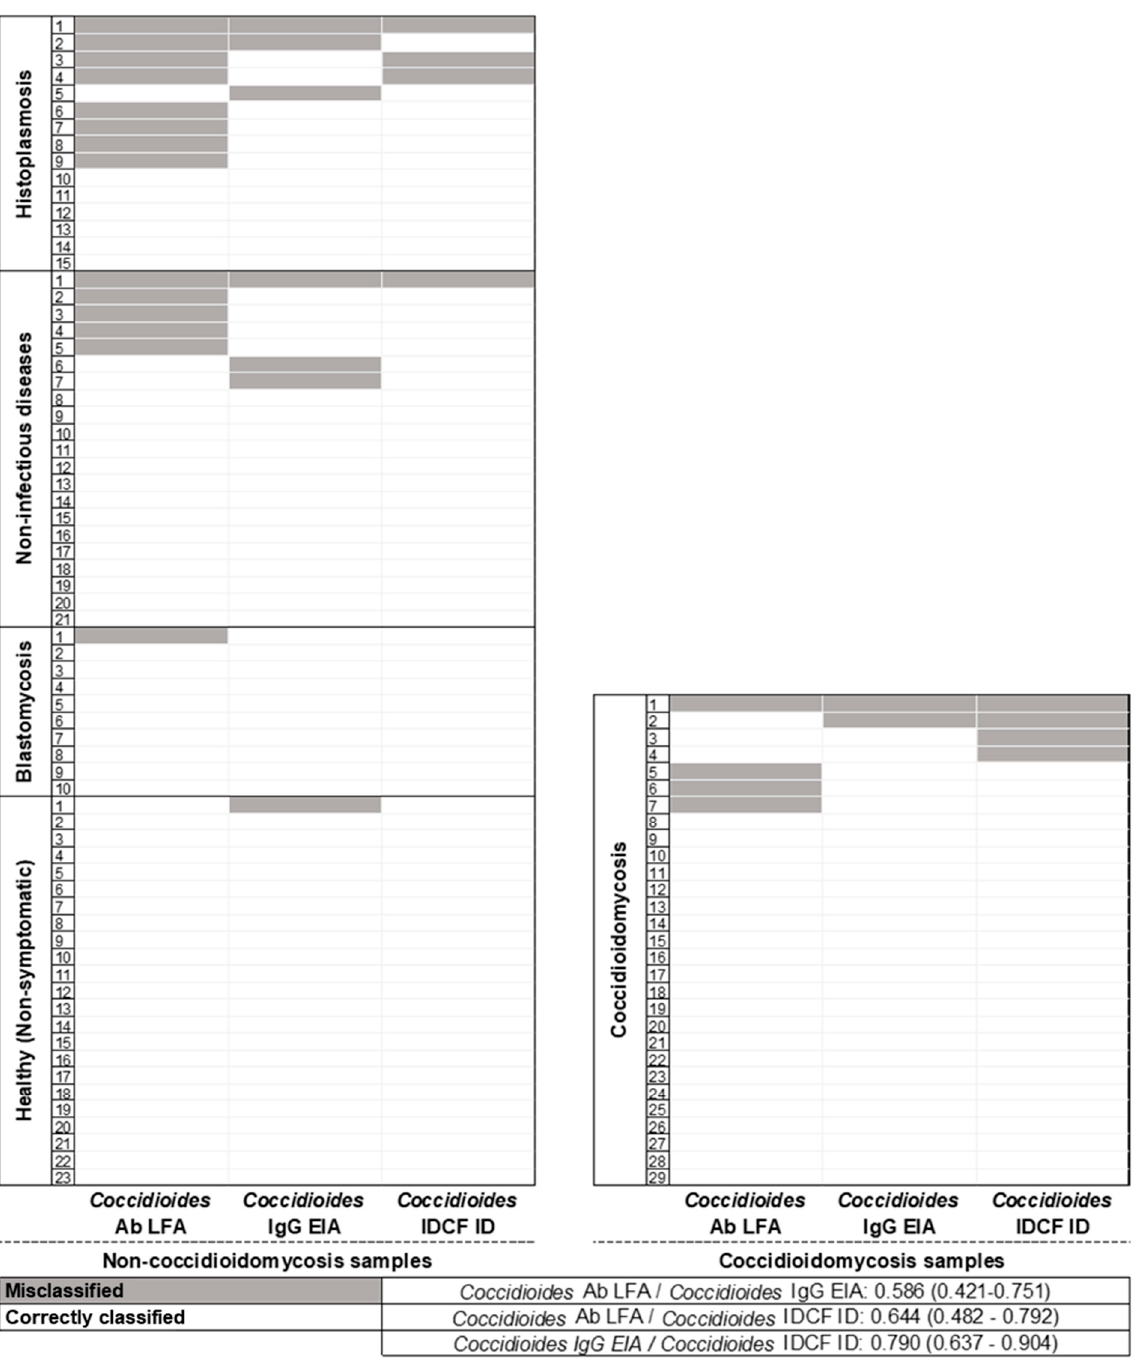
Figure 3. Concordance analysis of assays for the detection of Coccidioides Ab: Analysis of 98 dog sera tested using the IMMY ® s ō na Coccidioides lateral flow assay for the detection of total anti- Coccidioides Ab ( Coccidioides Ab LFA), the modified IMMY ® Coccidioides Enzyme Immunoassay for the detection of anti- Coccidioides IgG Ab ( Coccidioides IgG EIA), and the IMMY ® IDCF immunodiffusion for the detection of anti- Coccidioides IgG Ab ( Coccidioides IDCF ID).